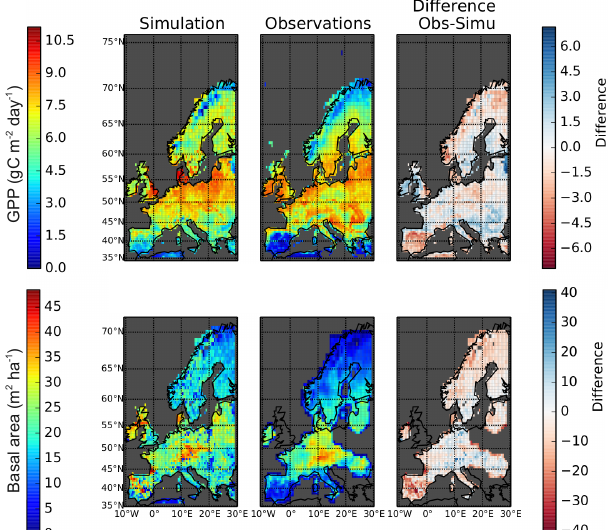
Figure 4. Comparison between observations and simulations of ORCHIDEE-CAN for gross primary production and basal area over Europe. Gross primary production represents the mean for June– August between 2001–2010 and basal area is the value at the end of